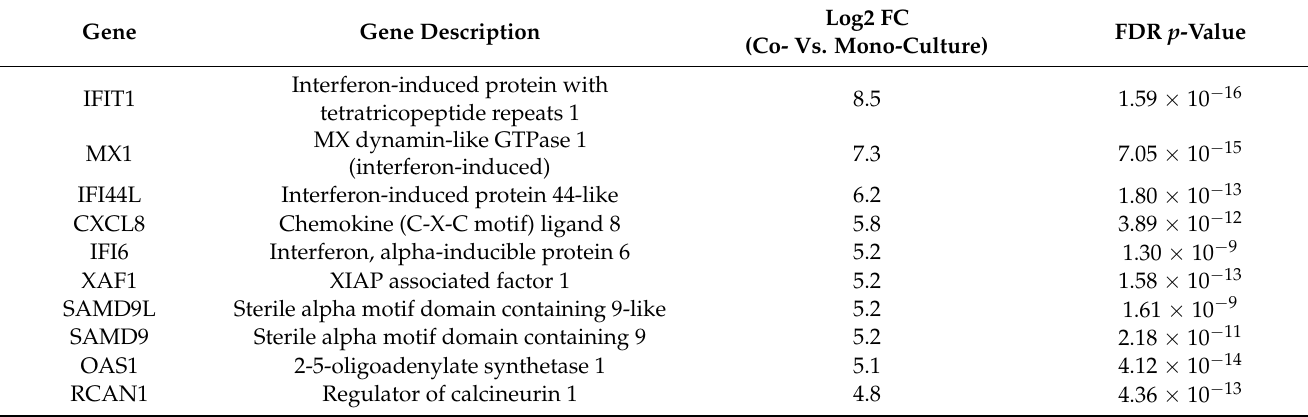
Table 1. Top ten upregulated genes in co-cultured pericytes.